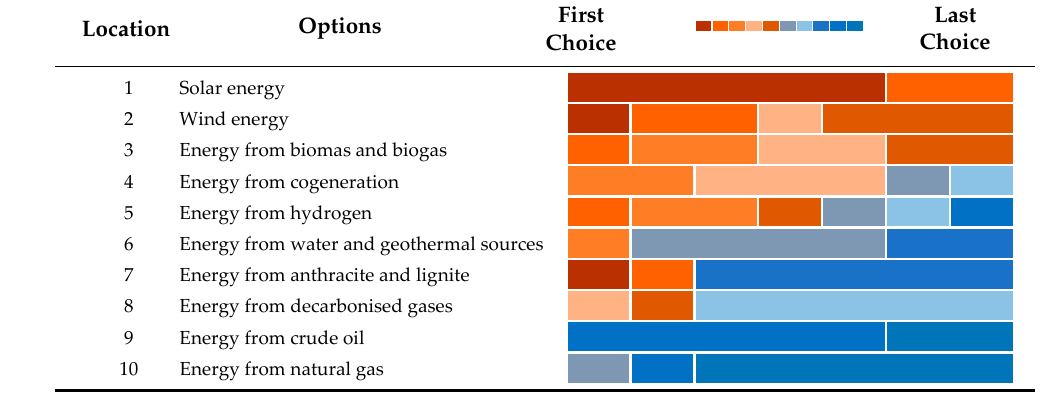
Table 2. Current priorities for financial, legal, organisational support of energy source development in the Eastern Poland macroregion.